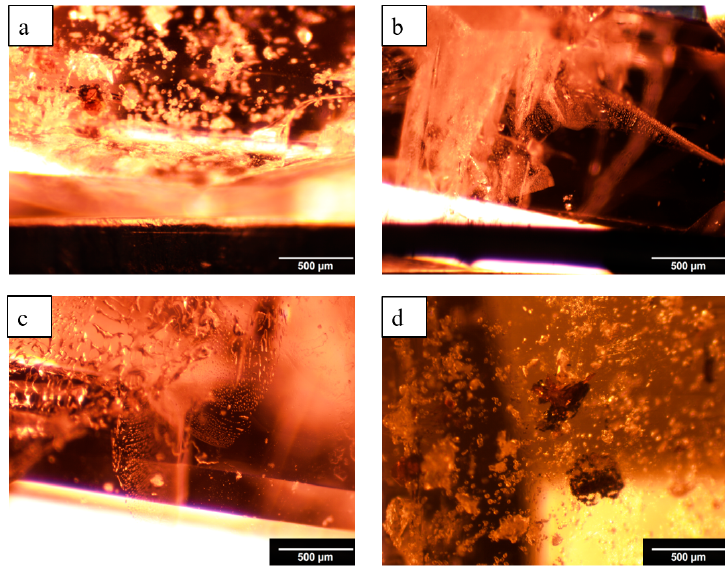
Figure 7. ( a ) Fluid inclusions of TO6. ( b , c ) Healed cracks inclusions of TO3 and TO7. ( d ) Dark solid inclusions of TO10.